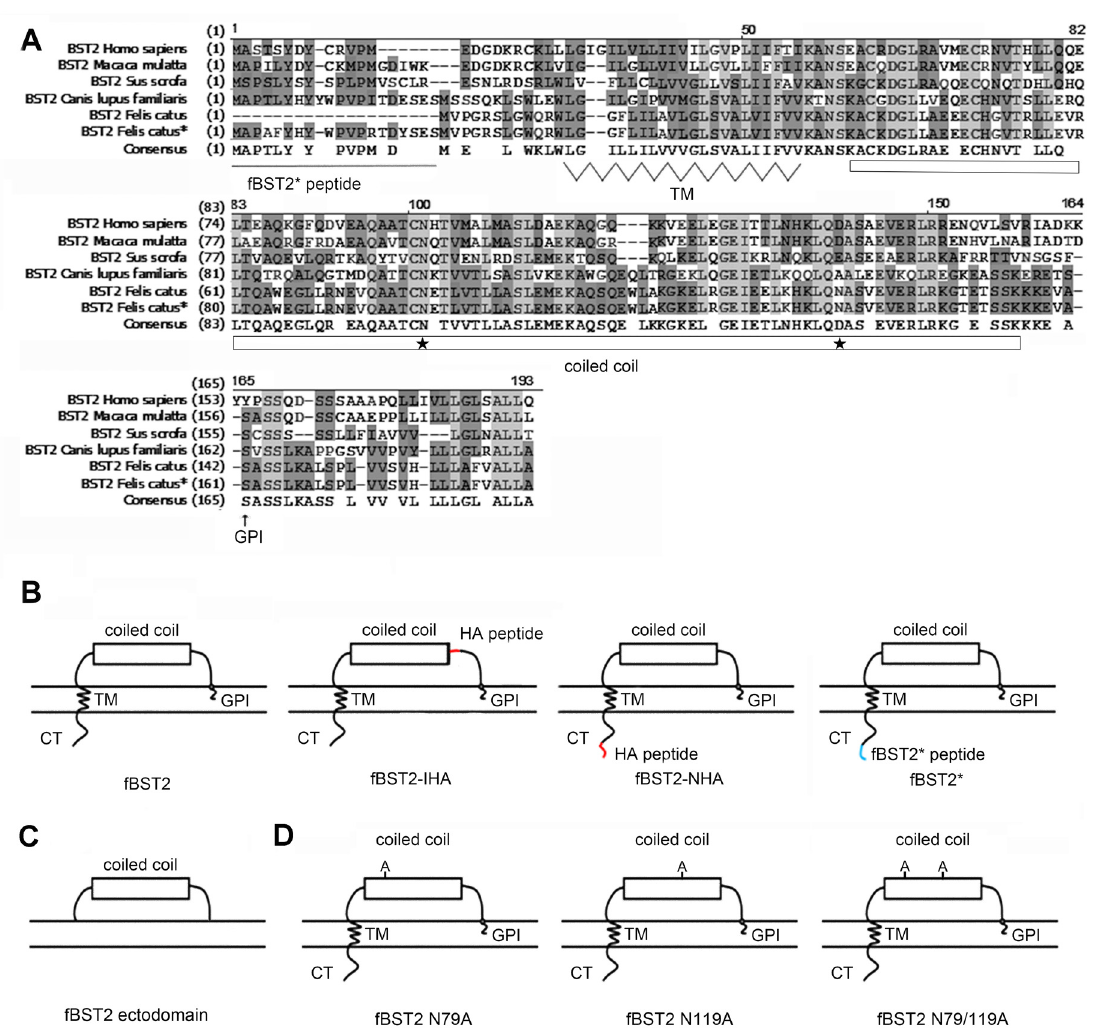
Fig 1. Amino acid sequence alignment and schematic representation of BST2s. (A) Amino acid sequence alignment of BST2s of H. sapiens, M. mulatta, S. scrofa, Canis lupus familiaris, F. catus and F. catus * . Identical amino acids are shaded in light grey, and conserved or similar residues are shown in dark gray. Dashes represent gaps. The transmembrane region, extracellular coiled-coil domain and GPI anchor, marked under the consensus sequences. The N-glycosylation sites in the extracellular coiled-coil domain are indicated by black stars. (B, C and D) Schematic representation of the fBST2 constructs used in this